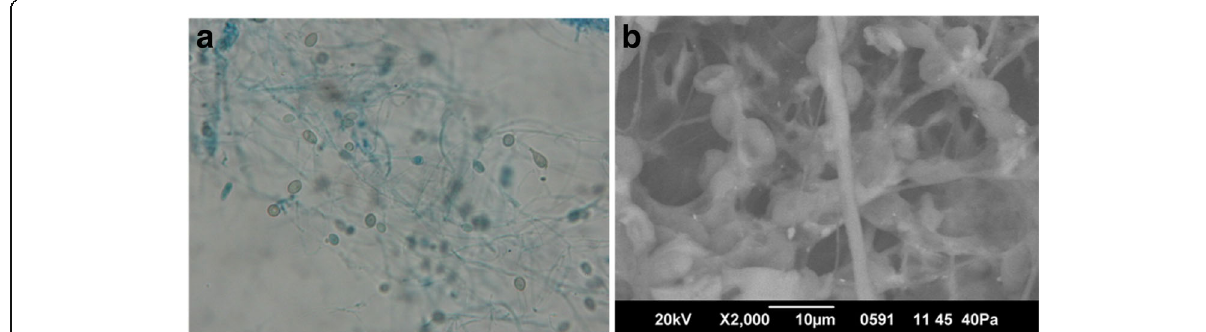
Fig. 1 Micrograph of Scedosporium apiospermum . a Optical microscopy of hyphae and conidia from a PDA culture, at 100× total magnification. Lactophenol cotton blue wet mount preparation. b Scanning electron microscopy of hyphae and conidia from a liquid culture grown in minimal salt medium plus crude oil as the sole carbon and energy